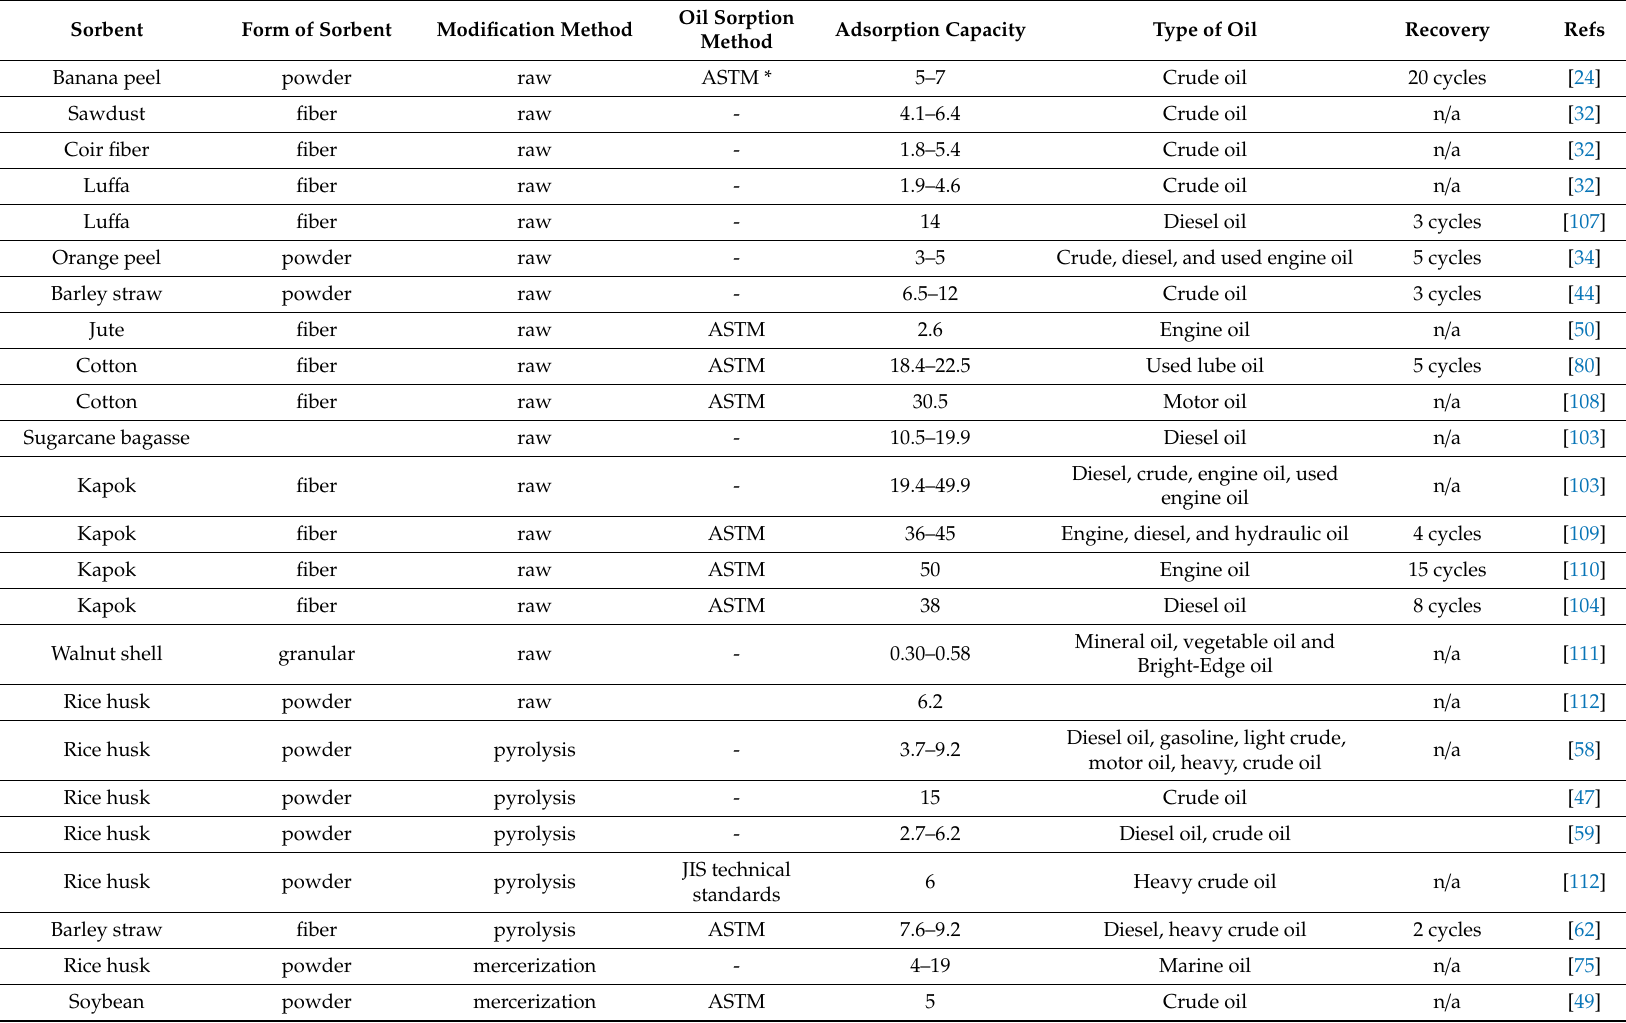
Table 1. Oil sorption capacity of selected lignocellulosic